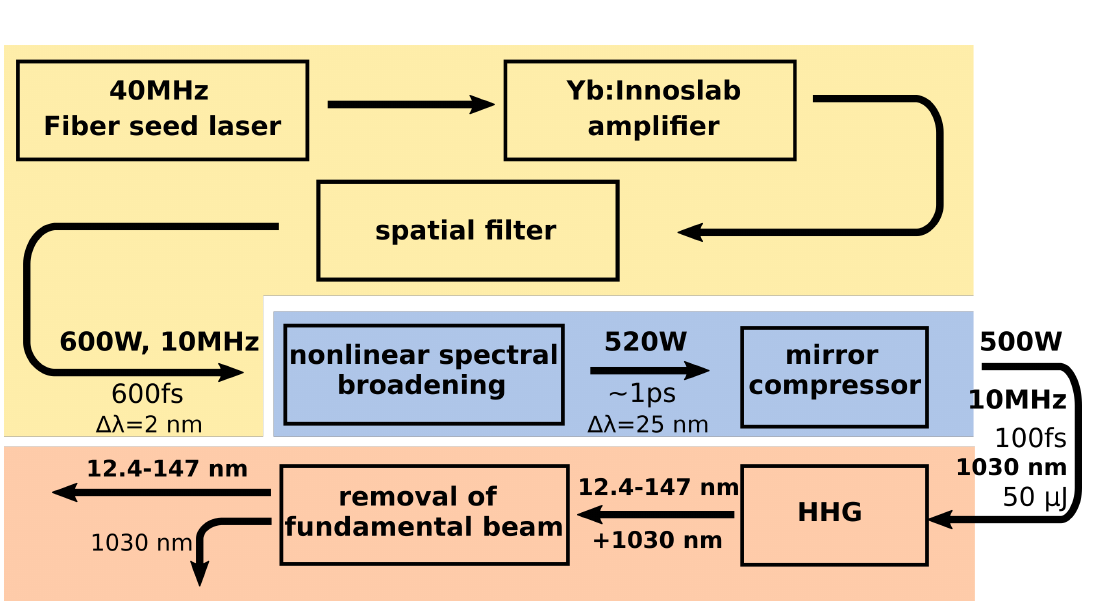
Figure 10: Schematic setup of Ju SPARC_SIRIUS for spin- and time-resolved electron momentum mi- croscopy, which consist of Innoslab amplifier (shaded yellow region) (Russbueldt et al., 2015), nonlinear compression using multi-pass cell (Weitenberg et al., 2017) (shaded blue region) and XUV-initiated HHG (shaded orange region).